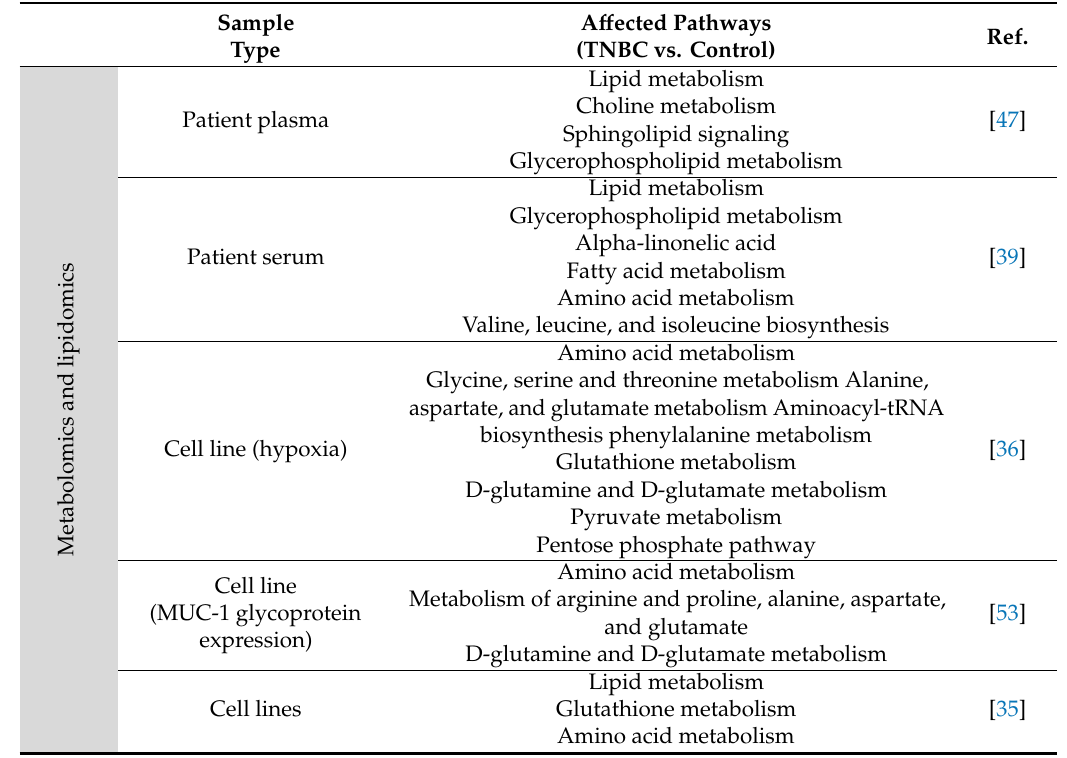
Table 1. Mass spectrometry (MS)-based omics description of triple-negative breast cancer (TNBC) metabolic